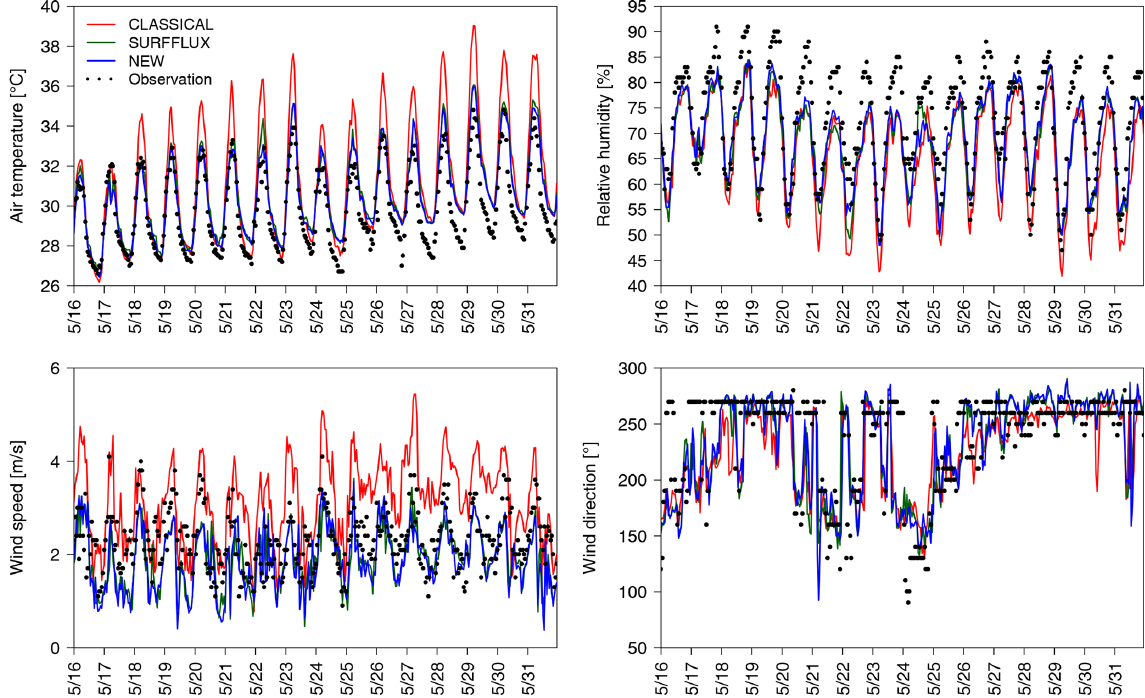
Figure 5. Time series (UTC) of simulated (D4) and observed meteorological variables at the KP station during